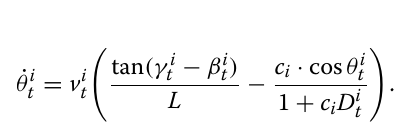
Proof See “Appendix